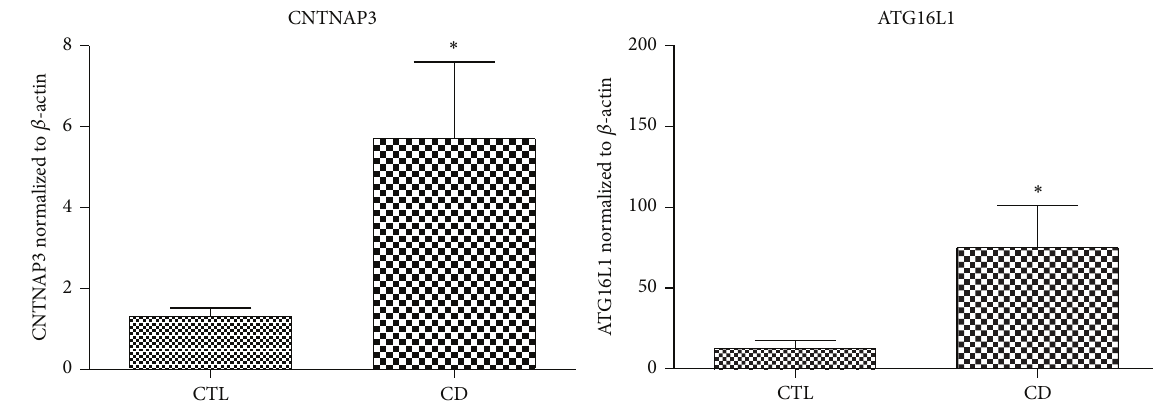
Figure 1: The mRNA expression of CNTNAP3 and ATG16L1 in Crohn’s disease. qRT-PCR showed that the levels of both CNTNAP3 ( 𝑃 = 0.029 ) and ATG16L1 ( 𝑃 = 0.024 ) were significantly high in CD patients compared to those in healthy controls.